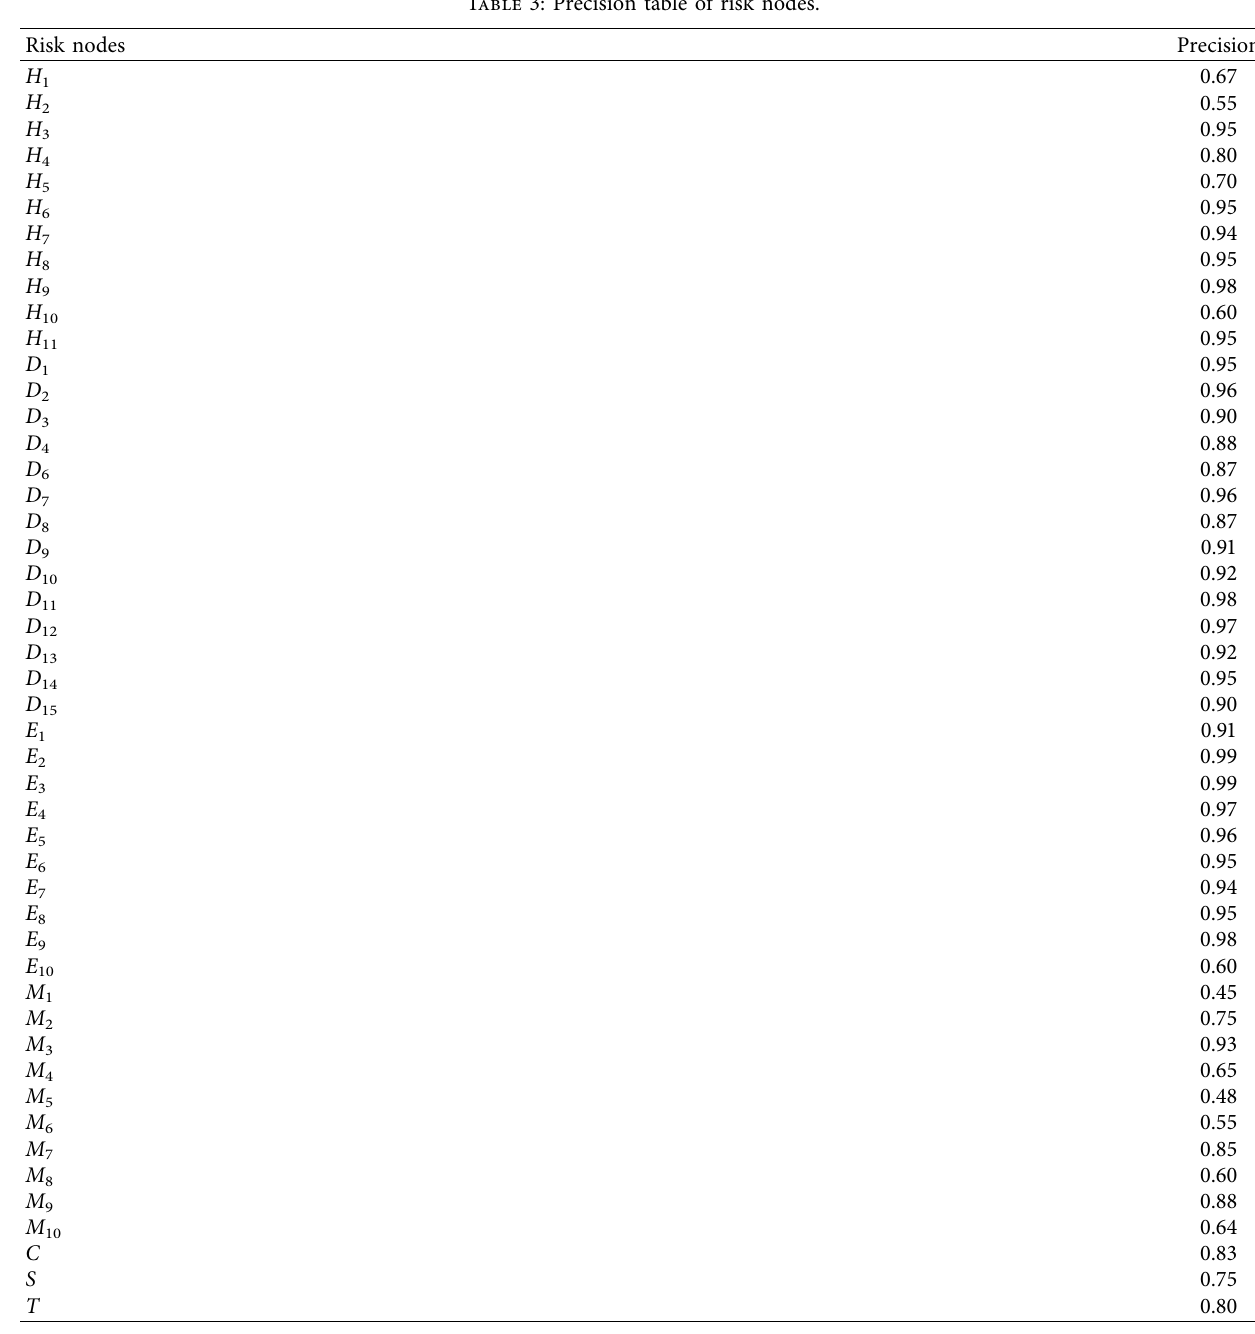
Table 3: Precision table of risk